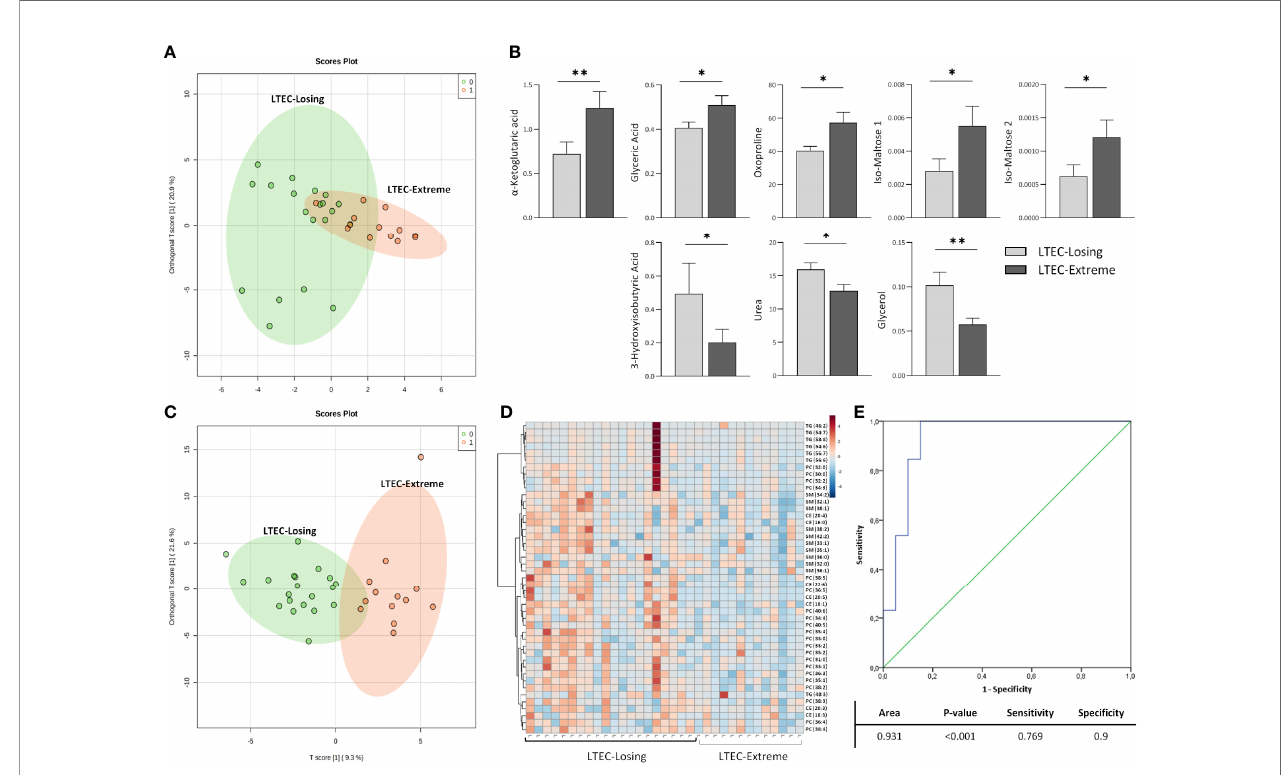
FIGURE 3 | Metabolomics and lipidomics analysis comparing long-term elite controller (LTEC)-extreme and LTEC-losing. (A) Orthogonal principal component analysis (ortho-PCA) including 78 metabolites between LTEC-extreme and LTEC-losing. (B) Column bars indicating differences in relative plasma concentrations of the principal signi fi cant metabolites (*P < 0.05; **P < 0.01) between LTEC-extreme and LTEC-losing. Light gray bars represent LTEC-losing, and dark gray bars represent LTEC- extreme (mean + SEM data). (C) Ortho-PCA of the 114 lipid species differentiating the LTEC-extreme from the LTEC-losing group. (D) Hierarchical clustering of the 45 signi fi cantly expressed lipids species between LTEC-extreme and LTEC-losing. Patients were ordered on vertical lines and candidate relative concentration of each lipid species on horizontal lines [sphingomyelin (SM), phosphatidylcholine (PC), triacylglycerol (TG), and cholesteryl ester (CE)]. The scale shows blue (low concentration) to red (high concentration). (E) Logistic regression and receiver operator characteristic (ROC) curves elucidate the statistically signi fi cant lipidomics pro fi le from the combination of 45 statistically signi fi cant lipid species as main differentiators between LTEC-extreme and LTEC-losing (area under the curve (AUC) =